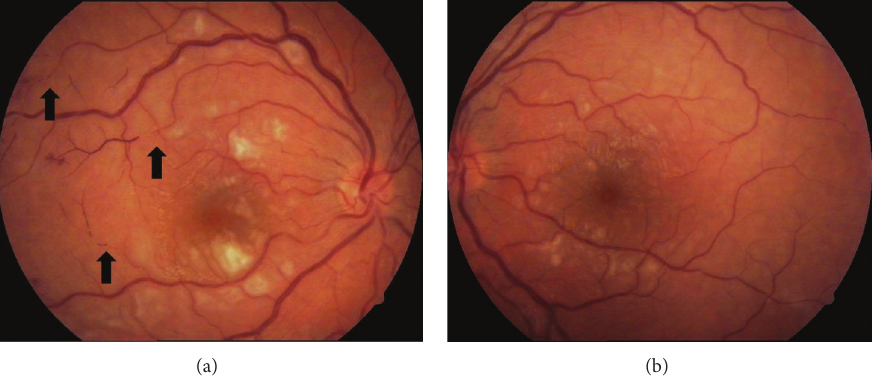
Figure 1: (a) Right eye, color fundus picture depicting widespread cotton-wool spots and arteriolar occlusion (Black arrows). (b) Left eye, color fundus picture showing multiple cotton-wool spots.